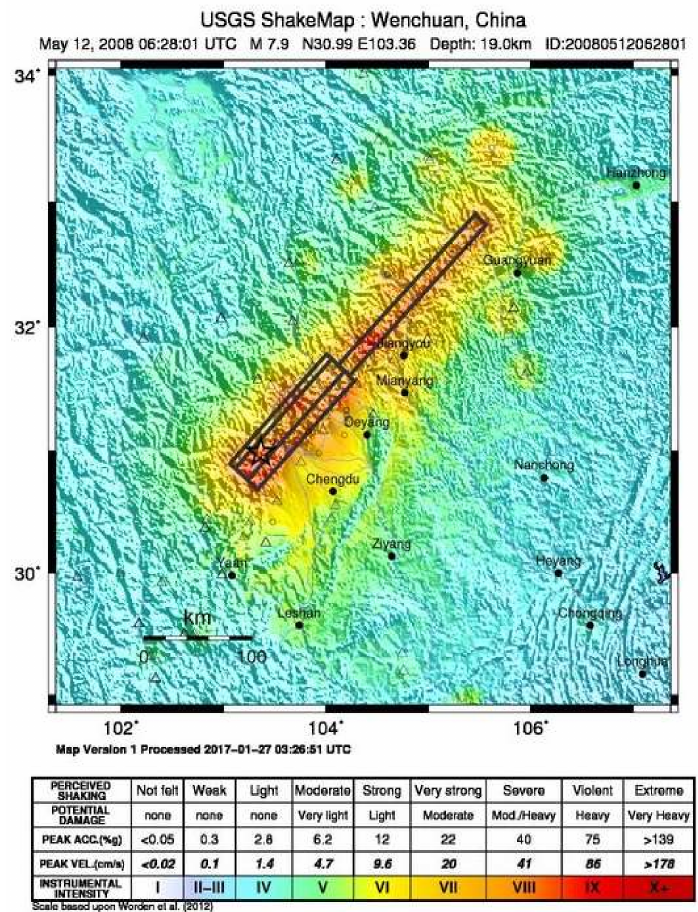
Figure A1. The USGS ShakeMap of the 2008 Wenchuan, China